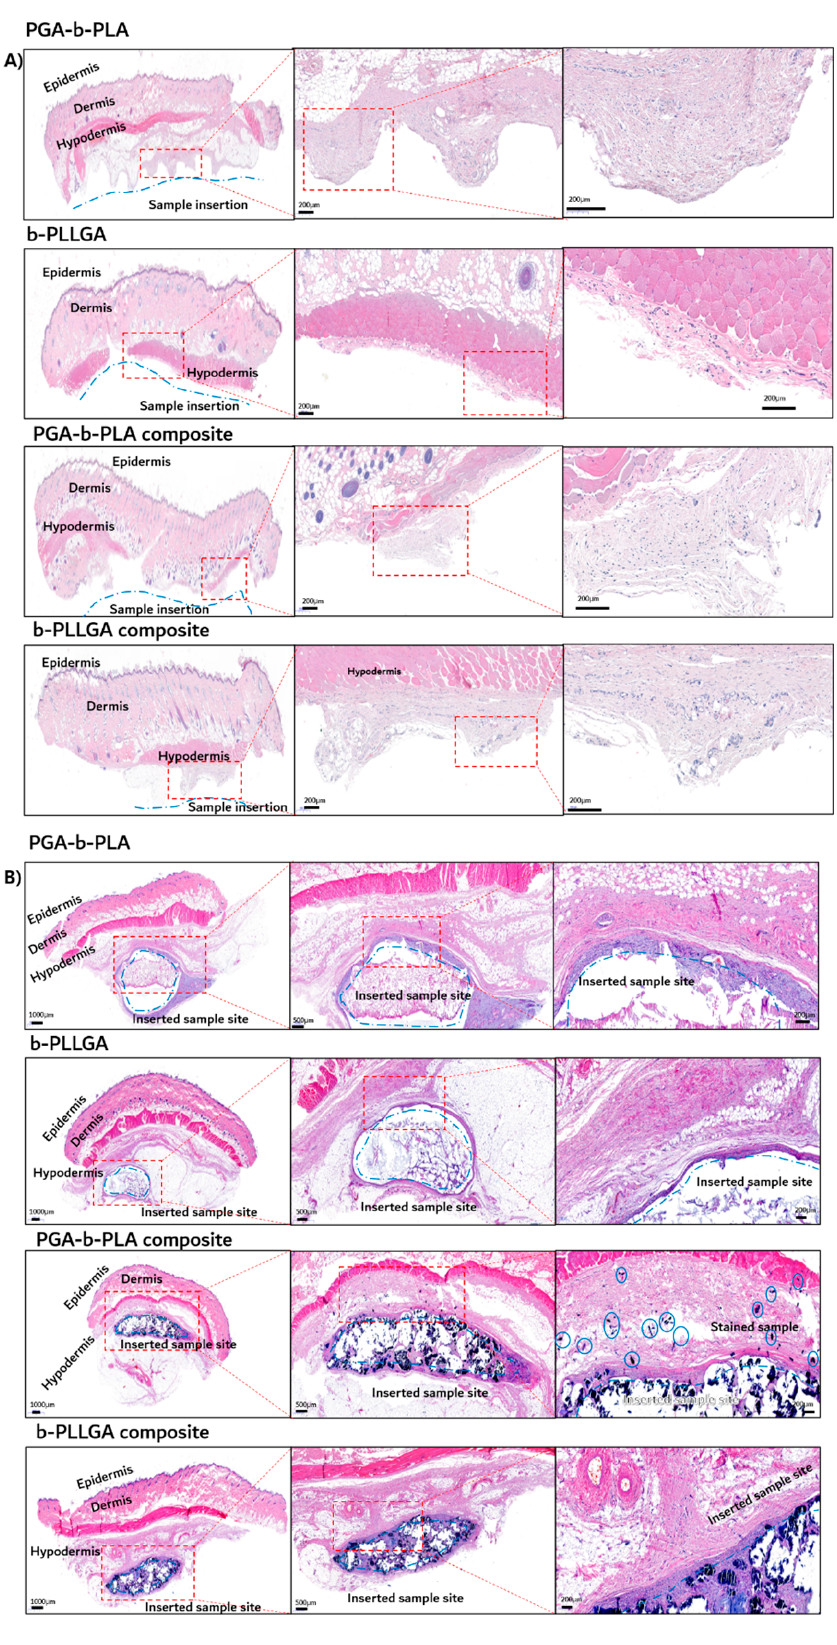
Figure 10. Histochemical analysis of the in vivo animal degradation test using H&E staining with insertion after 1 month ( A ) and H&E staining with insertion after 5 months ( B ).